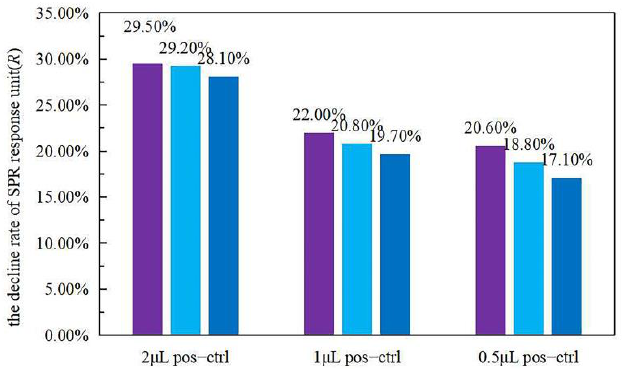
Figure 2. To compare the decline rates of SPR response units of the two instruments, the line graph represents the test results of Biacore T100 SPR biosensor, and the histogram represents the test results of the self-made SPR biosensor. This figure mainly compares the decline rate of SPR response unit ( R ) of positive control amplified for 15 cycles (pos − 15), positive control amplified for 35 cycles (pos − 35), and negative control amplified for 35 cycles (neg − 35) of two instruments. The volume of the positive and negative controls in this experiment was 2 μL .